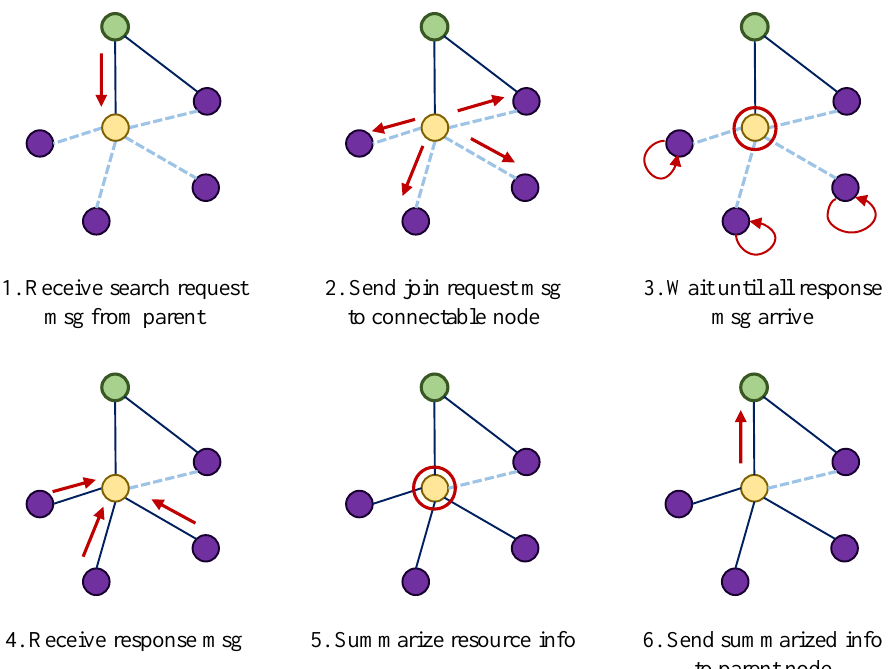
Figure 4. Sequence of resource search